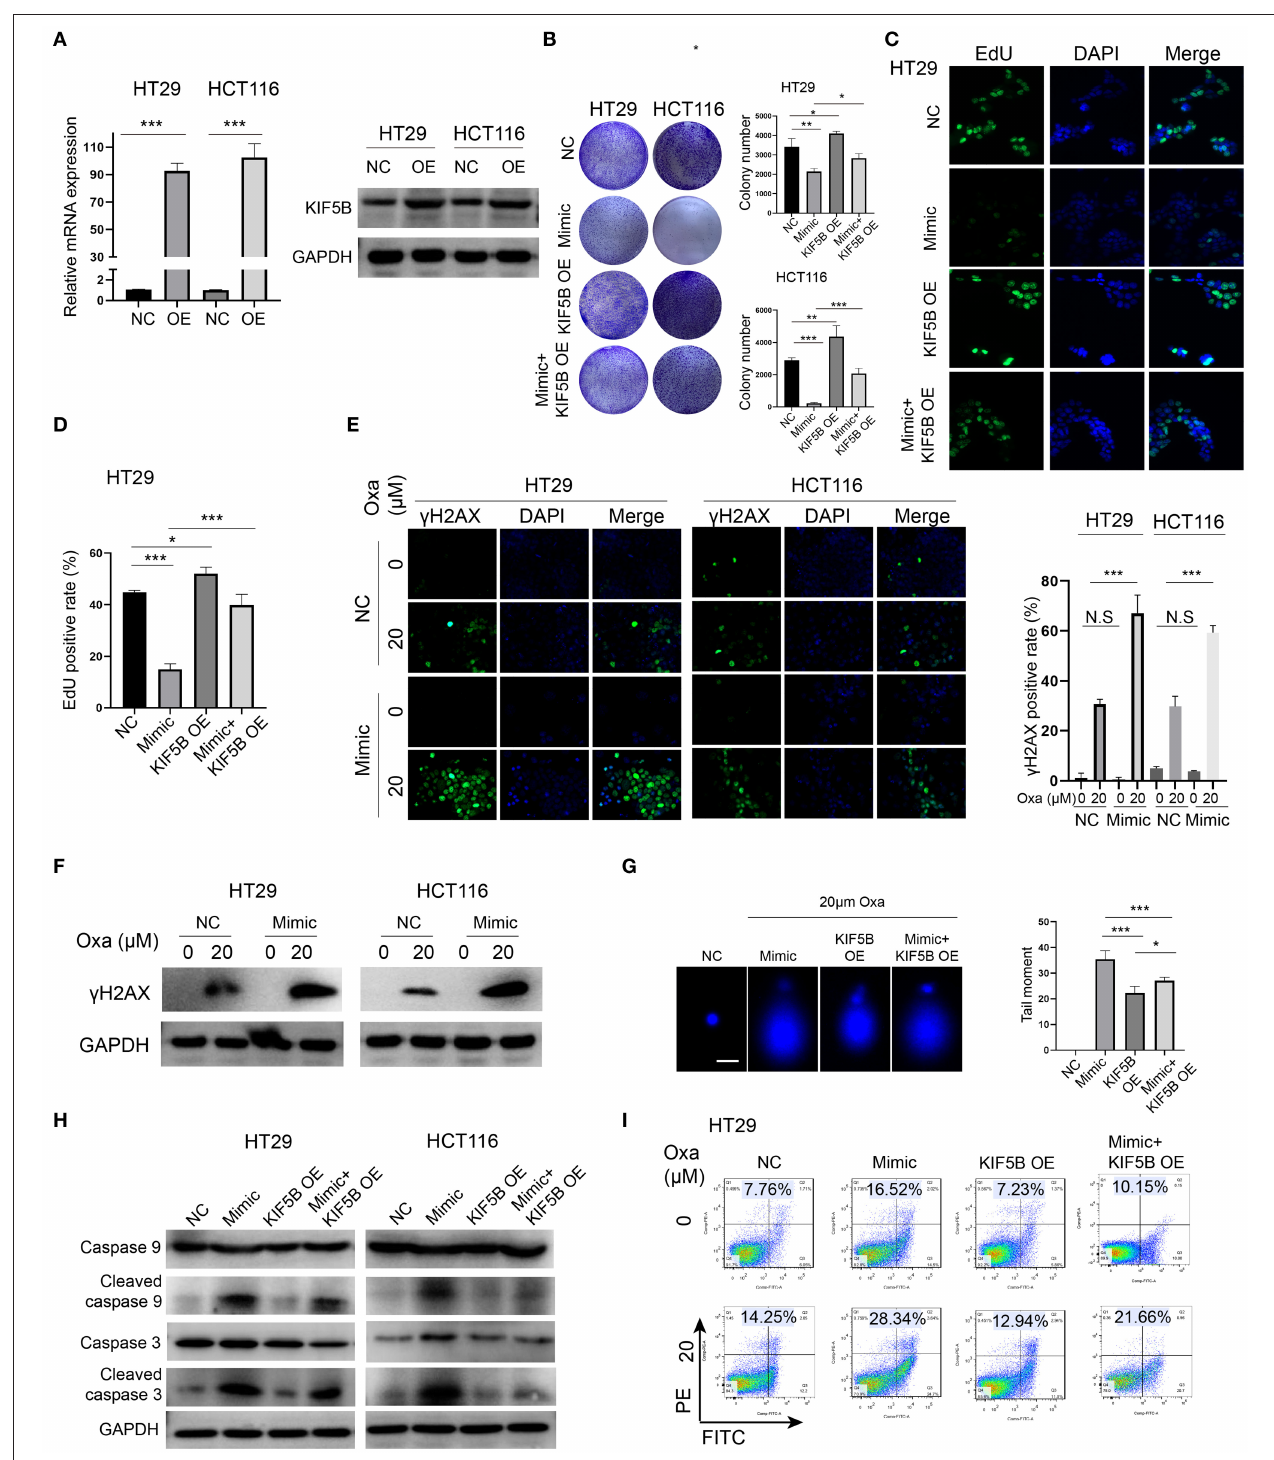
FIGURE 5 | Downregulation of KIF5B is critical for the miR-1278 mimic-mediated sensitization to oxaliplatin by promoting DNA damage and apoptosis. (A) KIF5B was overexpressed using a plasmid in HT29 and HCT116 cells as verified by qRT-PCR and Western blot. (B) The colony formation assay demonstrated that overexpression of KIF5B rescued the inhibitory effect of the miR-1278 mimic on colony formation in HT29 and HCT116 cells. (C,D) Overexpression of KIF5B significantly rescued the inhibitory effect of the miR-1278 mimic on HT29 cell proliferation. (E,F) γ h2AX served as a sensitivity marker for DNA damage and